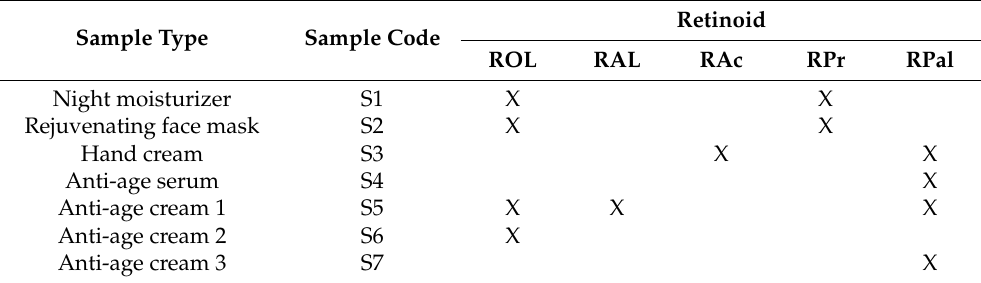
Table 2. Summary of the declared retinoids in the cosmetic